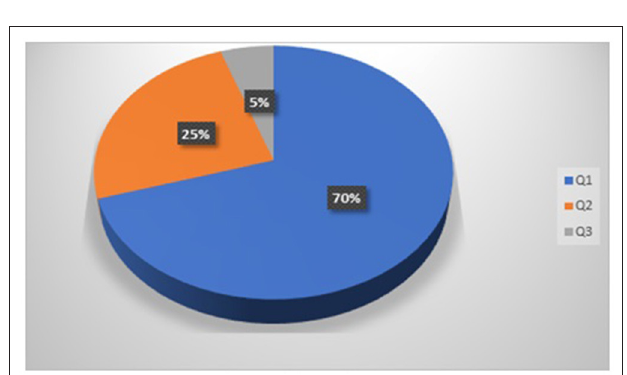
FIGURE 6 | Quartile of the location of the magazines. Source: the